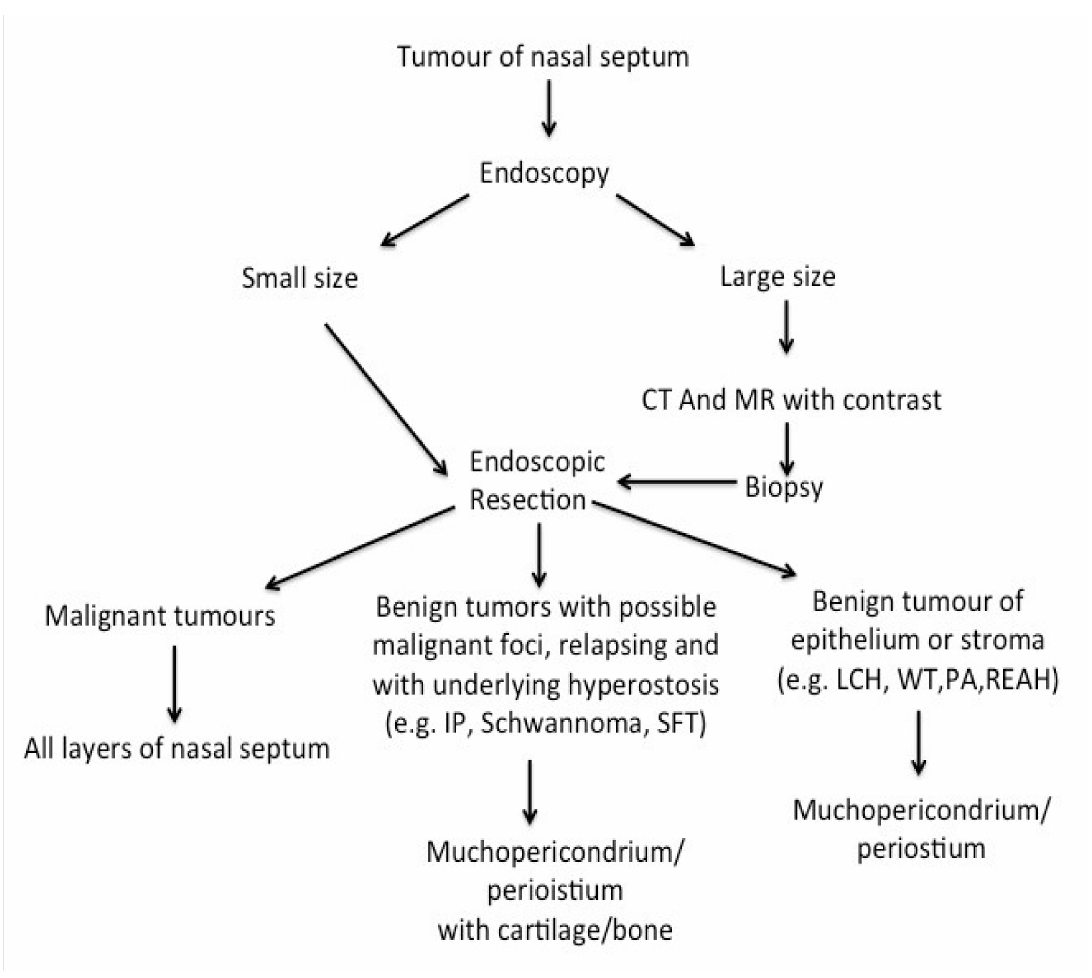
Figure 3. Flow diagram for management of tumour of nasal